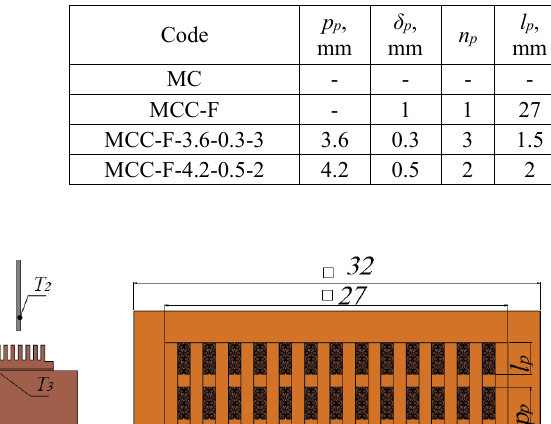
Table 2. Specimen code and